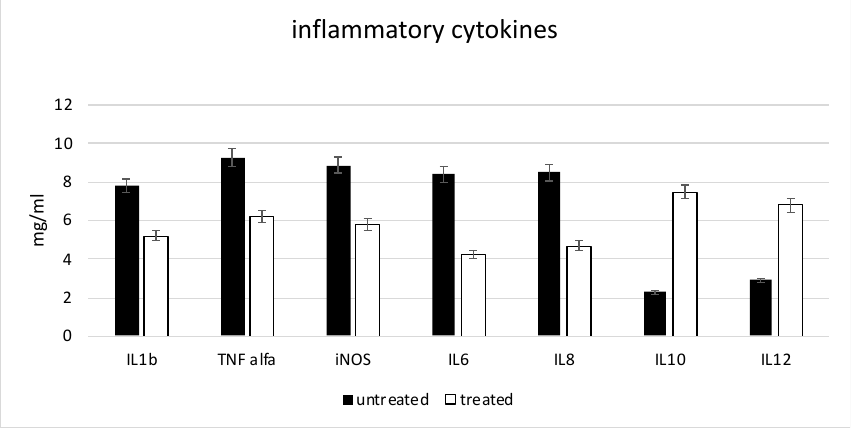
Figure 5. Gene expression related to the inflammatory markers. All the cells were cultured in the presence of an inflammatory condition; the black bars in the absence of the CMF, the white bars in the presence of the CMF.